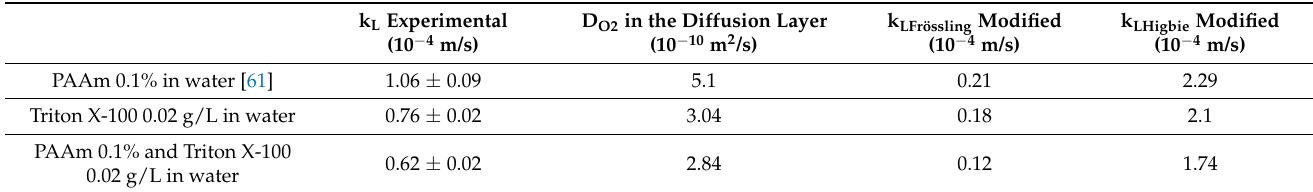
Table 4. Diffusion coefficient estimated in the diffusion layer and corrected theoretical k L .